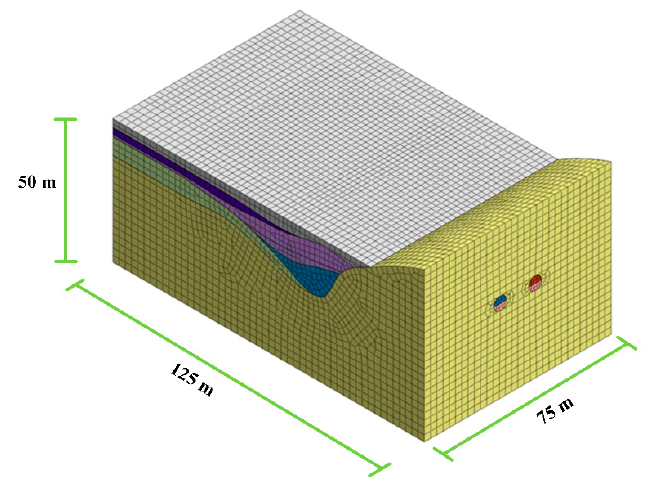
Figure 9. Numerical model of tunnel.